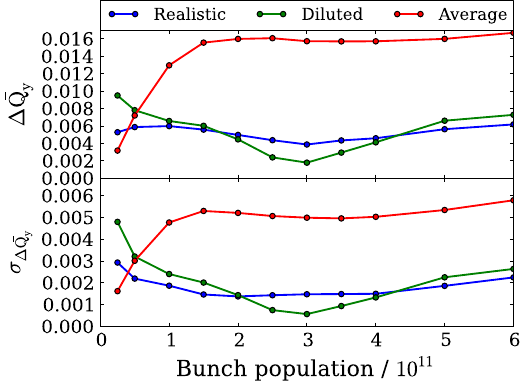
grey.FIG. 13. The horizontal tune shift (upper graph) and its standard deviation (lower graph) as a function of bunch pop- ulation in a dipole magnet. The blue curve shows the results for a nonuniform cloud. The green curve shows the results for the uniform, diluted cloud. The red curve corresponds to the uniform ¼ 1 . 4 cloud. The SEY is δ max